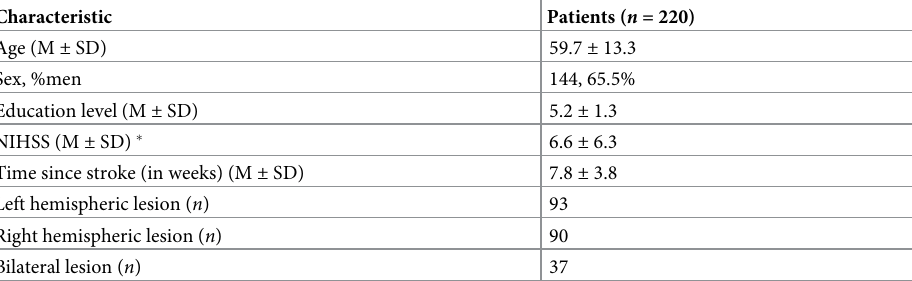
Table 1. Clinical characteristics of the patient